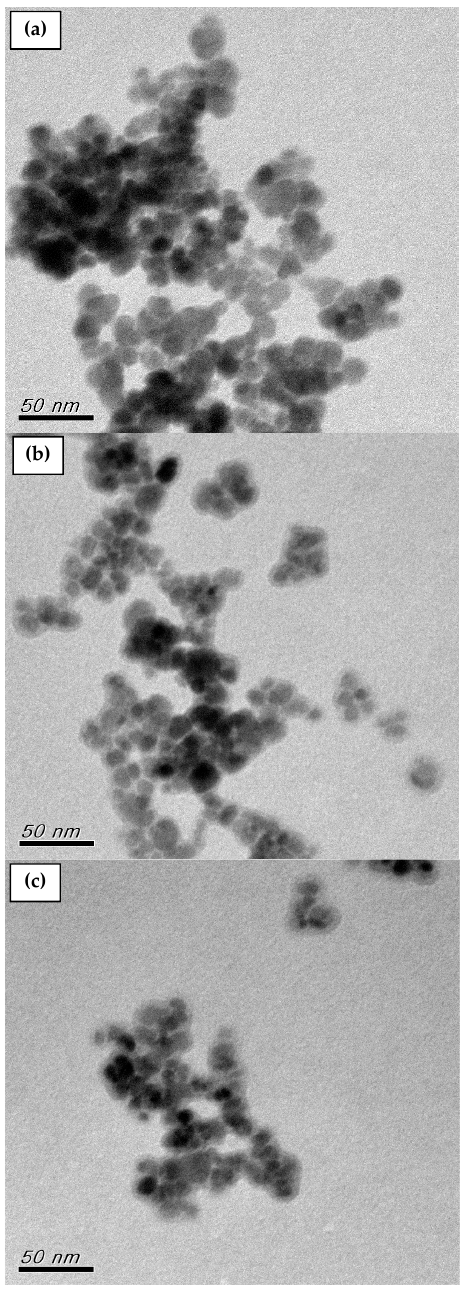
Figure 4. TEM images of as-synthesized ( a ) MNP, ( b ) MNP-F127-2, and ( c ) MNP-F127-3 nanocom- posites.